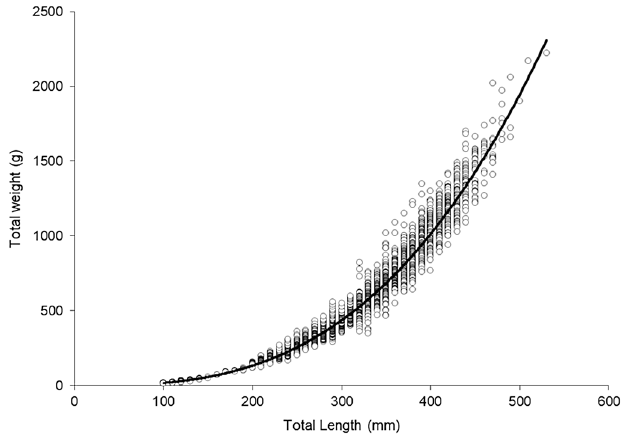
Fig. 4. Weight – length relationship for pooled sexes of Pagrus pagrus sampled in southern Brazil between 1976 and 1985 ( n = 2963). Continuous line indicates the regression line ( W = 1.735 × 10 − 5 × TL 2.9790 ; R 2 = 0.9814).